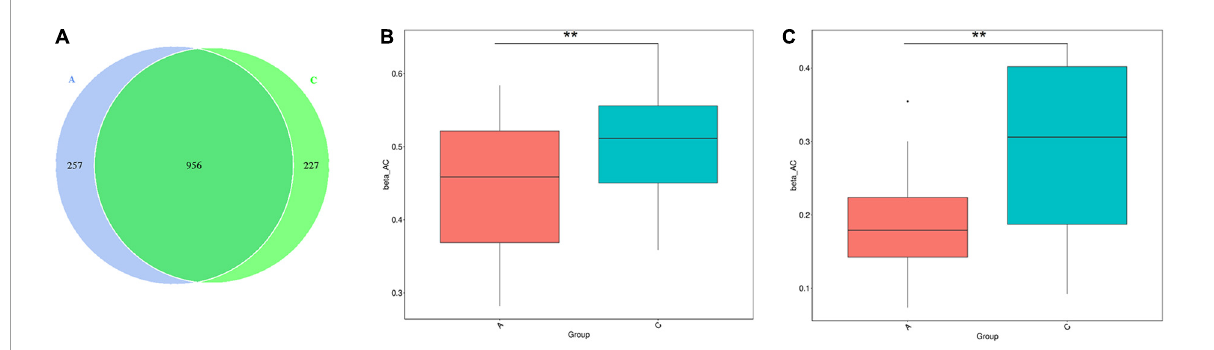
FIGURE2 Gut microbiota diversity in APP/PS1 and wild-type mice. The Venn diagram illustrates the overlap of the OTUs identified in gut microbiota between the two groups (A) . β -diversity of the gut microbiota between the two groups according to t-test of unweighted (B) and weighted (C) UniFrac distance. Groups: A, APP/PS1 double-transgenic mice; C, wild-type control group of C57BL/6J mice; n = 8/group. ** P < 0.01.